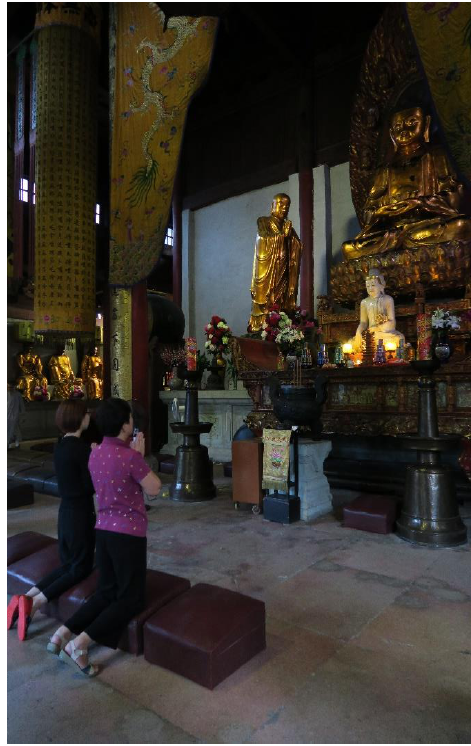
Figure 27. World of Buddhas of Guoqing Si.